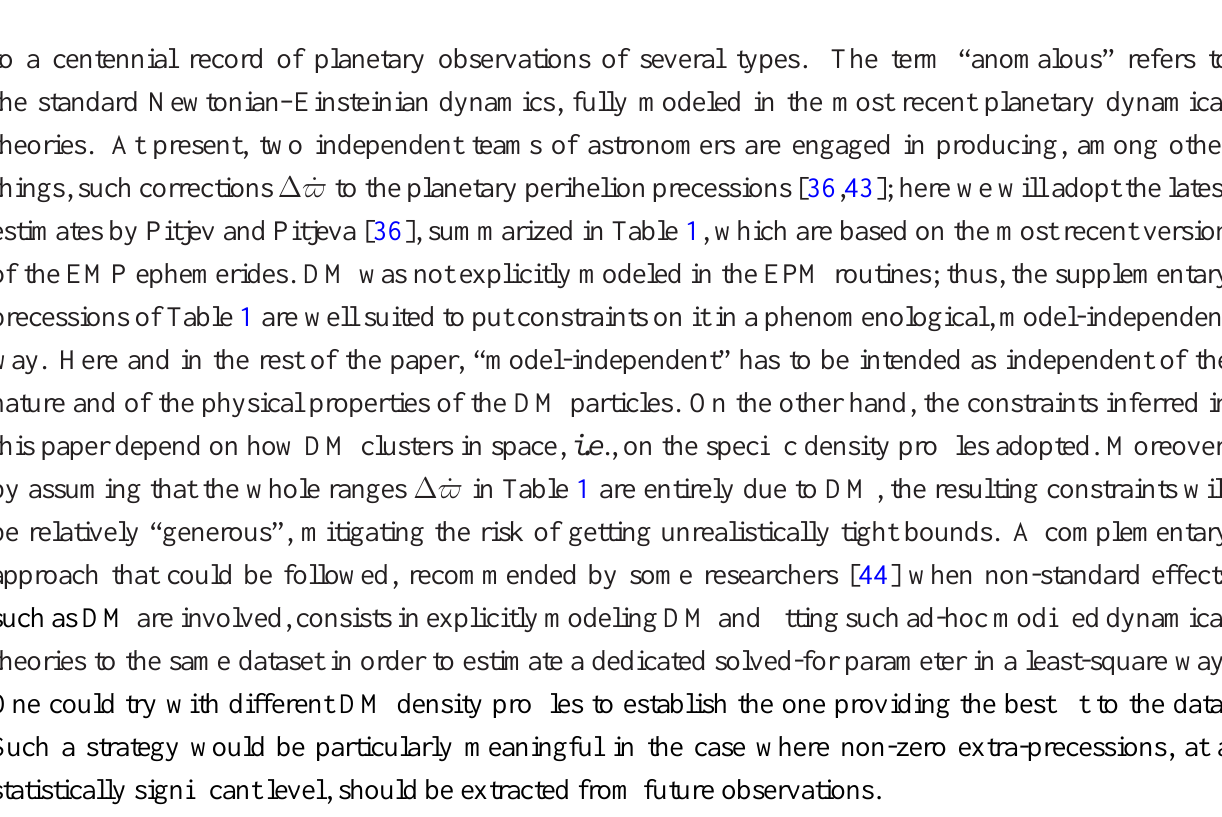
Table 1. Supplementary precessions ∆ ˙ ̟ of the longitudes of the perihelion for some planets of the Solar System estimated by Pitjev and Pitjeva [36] with the EPM2011